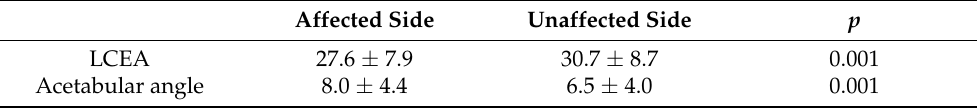
Table 1. 41 patients (43.2%) from the total group ( n = 93 with unilateral SCFE) had a dysplastic socket anatomy on the affected side with at least one of the following criteria: LCEA < 20.0 ◦ , acetabular angle > 10.0 ◦ . At the last time of follow-up, the affected side had a decreased coverage compared to the unaffected hip. However, the mean values of both sides were in a physiological range and the clinical relevance might be limited with differences between 1.5 ◦ (acetabular angle)–3.1 ◦